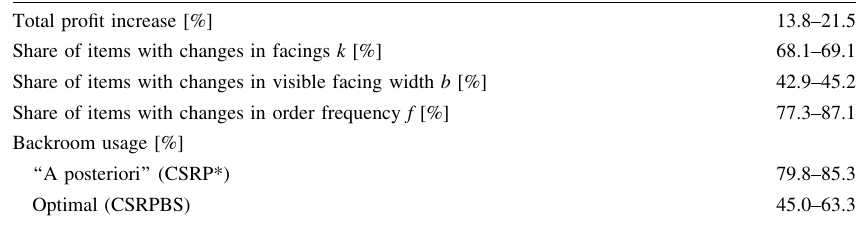
Table 5 Impact of neglecting replenishment and inventory costs on profits and solution structure for varying backroom